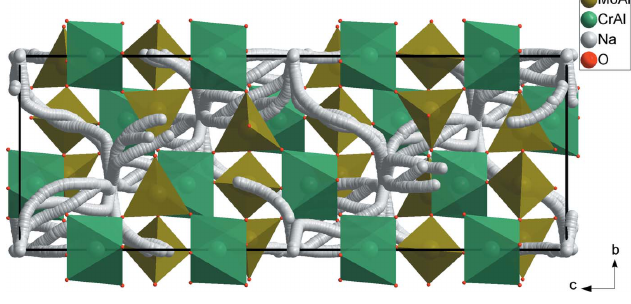
Figure 6 Modelling of the Na + pathway in Na 0.72 (Cr 0.48 ,Al 1.52 )(Mo 2.77 , Al 0.23 )O 12